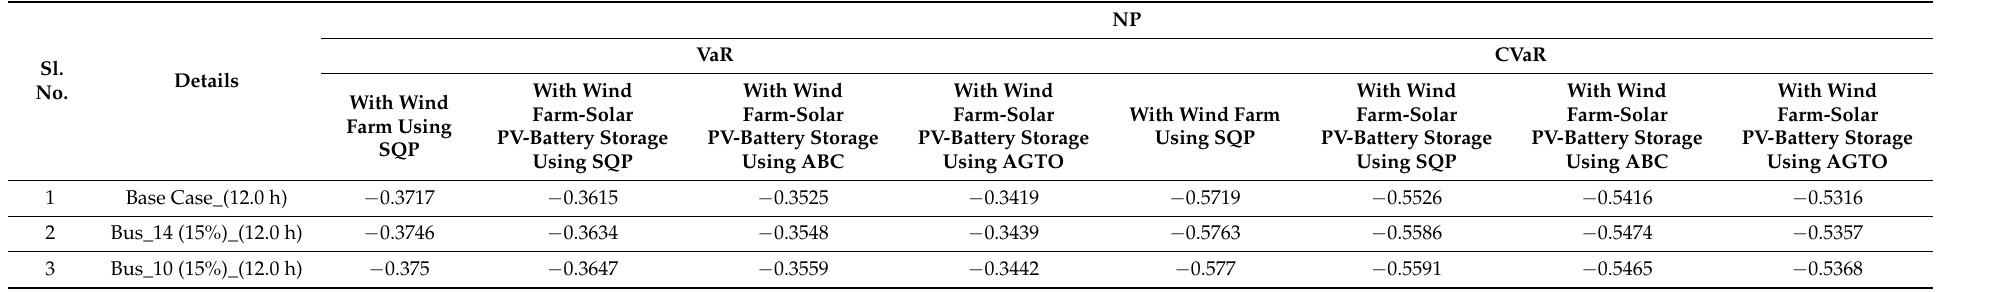
Table 8. System risk with different optimization techniques (for